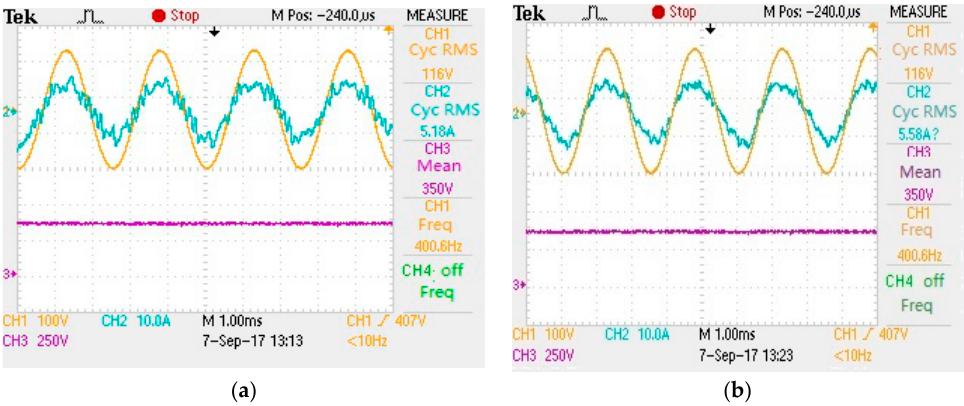
Figure 15. AC side voltage and current at inductance parameter changes ( a ) Traditional MPC ( b ) Online parameter estimation algorithm of MPDPC.